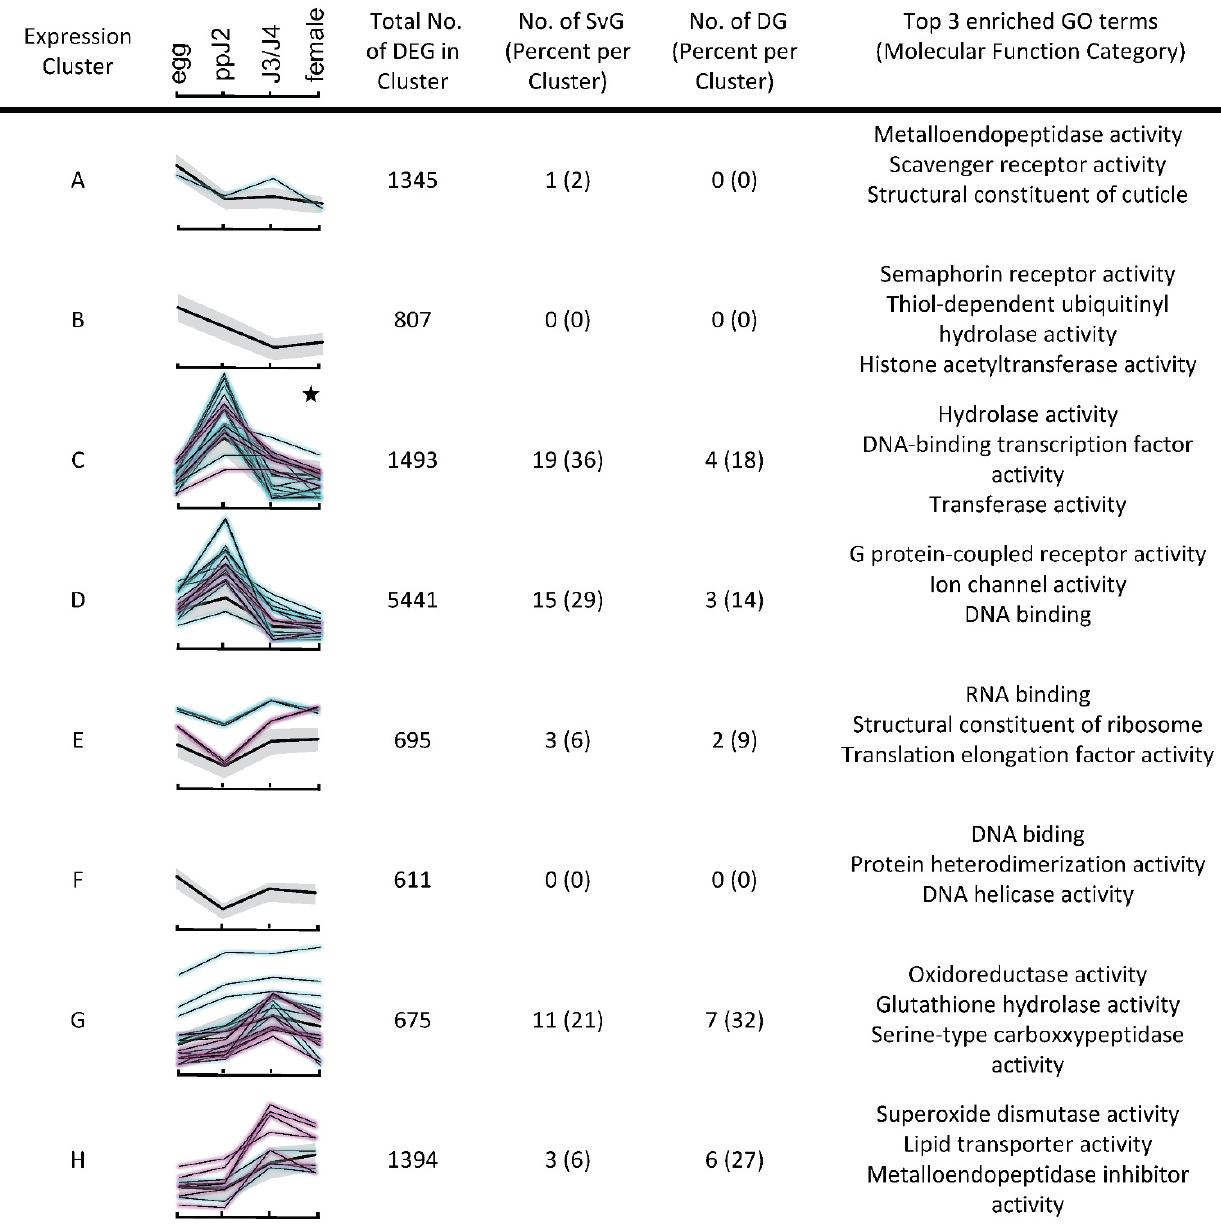
Figure 3. Temporal gene expression profiles throughout M. incognita infection. Hierarchical clustering identified 8 distinct temporal patterns of differentially expressed genes and known effector genes (SvG and DG effectors in cyan and magenta lines, respectively). The x axis represents four developmental stages. Black stars indicate clusters significantly enriched in the cellular component term ‘extracellular region’. Black lines represent the average profile for each cluster.